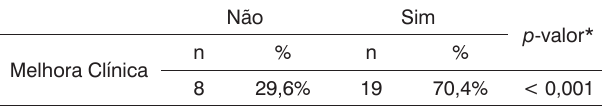
Tabela 3. Análise da evolução clínica após a punção do seio maxilar.